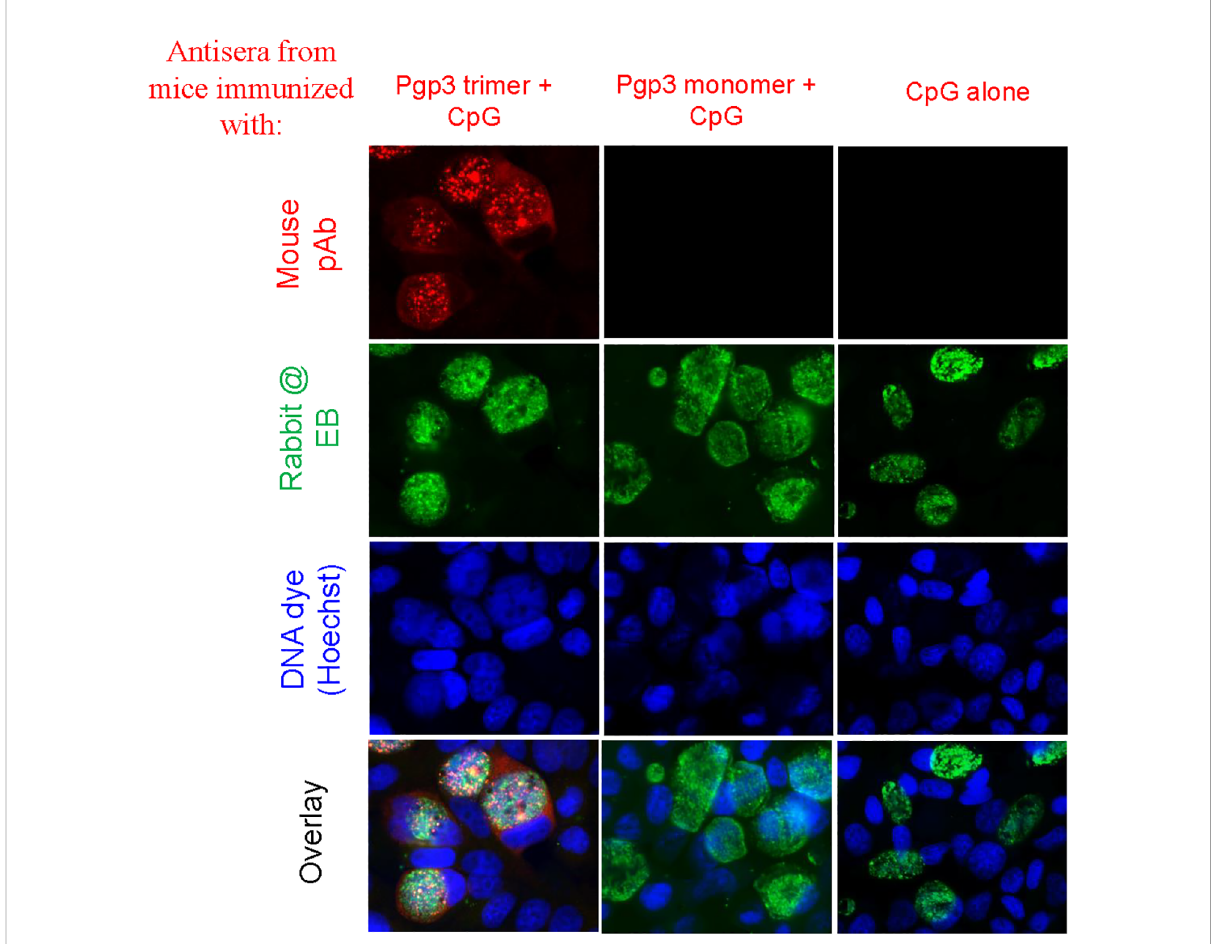
FIGURE 2 Detection of antibodies against endogenous Pgp3 in C. muridarum -infected cell samples. Sera collected from each group were used to detect endogenous Pgp3 by an immuno fl uorescence assay. C. muridarum -infected cells were costained with mice antisera (red) as indicated at the top of the fi gure, rabbit anti-chlamydial EB polyclone antibody (green), and DNA dye (blue). Only Pgp3 trimer-immunized mice produced antibodies that recognized endogenous